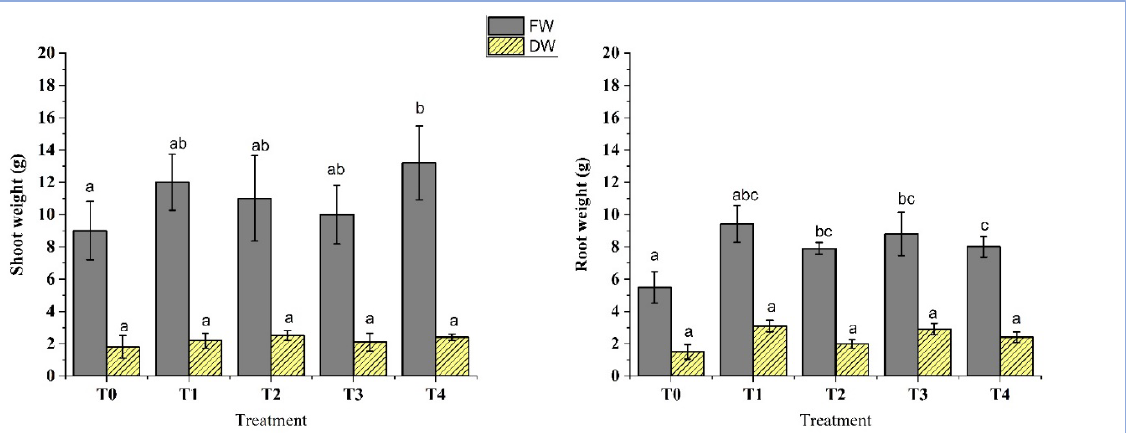
Figure 8. Effects of isolates inoculation on SFW, SDW, RFW and RDW of plants. Error bars represent Means ± S.D of three replicates. Different letters above columns indicate statistically significant differences at p ≤ 0.05.